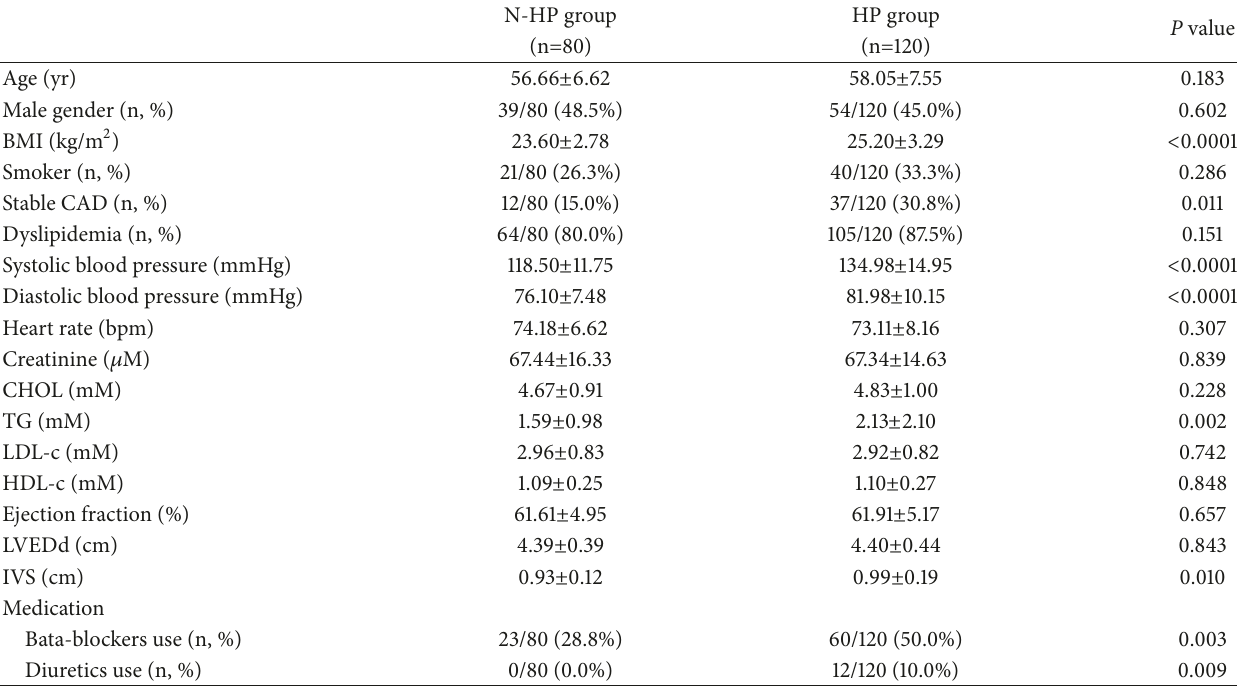
Figure 1: HRV and HRT analysis of N-HP and HP groups; ∗ P < 0.05; ∗∗ P < 0.01. HRV, heart rate variability; HRT, heart rate turbulence; N- HP, nonhypertensive; HP, hypertensive; SDNN, standard deviation of NN intervals; SDANN, standard deviation of all 5-minute average NN intervals; rMSSD, square root of mean of the sum of squares of successive NN interval differences; pNN50, number of successive NN intervals differing by > 50ms divided by the total number of successive NN intervals; VLF, very low frequency; LF, low frequency; HF, high frequency; TO, turbulence onset; TS, turbulence slope. Table 1: Clinical characteristic of N-HP group and HP